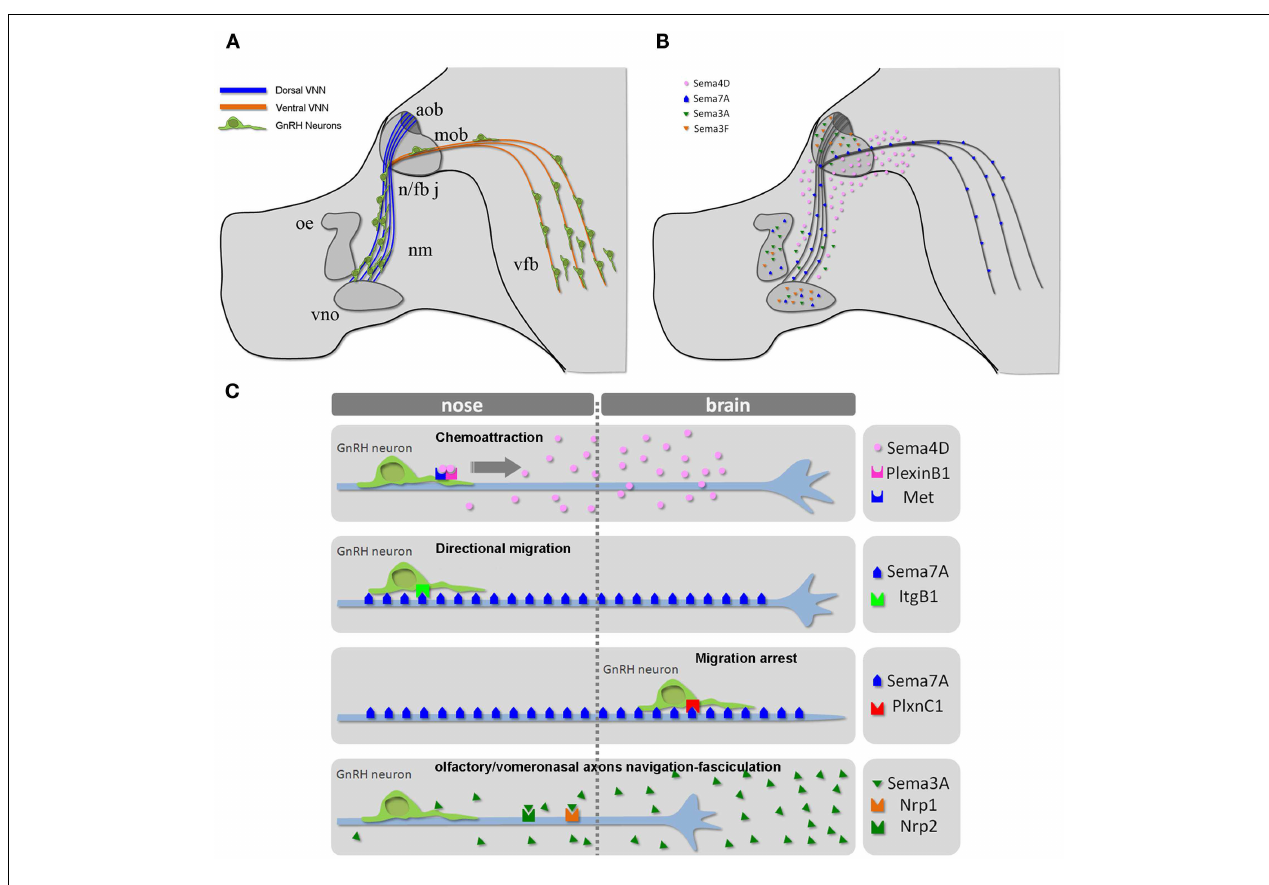
semaphorins on GnRH cell motility and/or vomeronasal axonal navigation. Abbreviations:VNN, vomeronasal nerve; cx, cerebral cortex; ob, olfactory bulb; nm, nasal mesenchyme; oe, olfactory epithelium; vno, vomeronasal organ; n/fb j, nasal/forebrain